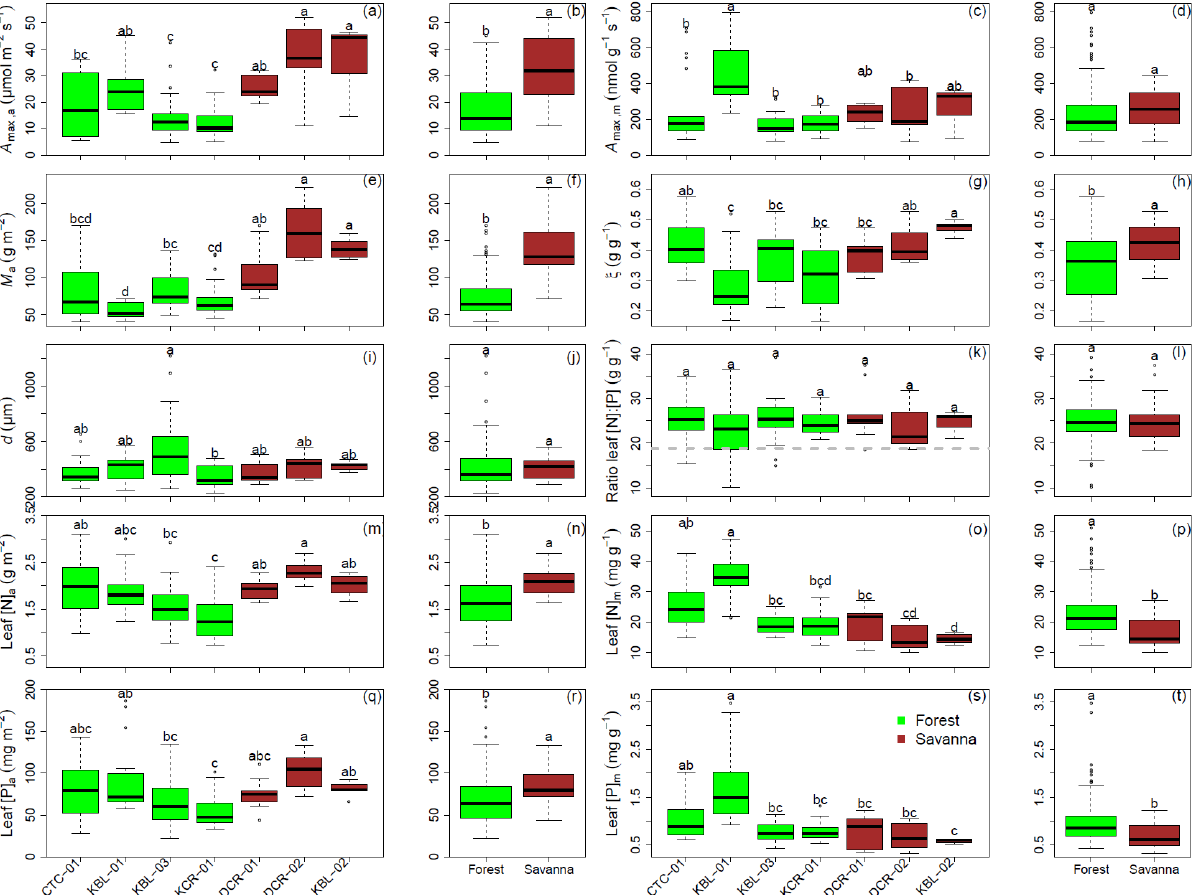
Figure 1. Paired boxplots of key leaf traits (untransformed data) by site and V . The two V classes are distinguished by colour: green for forest and brown for savanna. Site abbreviations are laid out in Table 2. Leaf traits are photosynthetic capacity (a, b) per unit leaf area and (c, d) per unit leaf dried mass; (e, f) leaf mass per unit area; (g, h) leaf dried matter content; (i, j) leaf thickness; (k, l) ratio of total leaf nitrogen to phosphorus; total leaf nitrogen (m, n) per unit leaf area and (o, p) per unit leaf dried mass; total leaf phosphorus (q, r) per unit leaf area and (s, t) per unit leaf dried mass. The box and whiskers show the median result as a thick horizontal band, the ends of the box denote the interquartile range; the whiskers extend 1.5 times the interquartile range or to the most extreme value, whichever is smaller; any points outside these values are shown as outliers. The grey dashed line in plot k represents a mean N:P ratio of 18.8 reported for tropical forests by Reich et al.